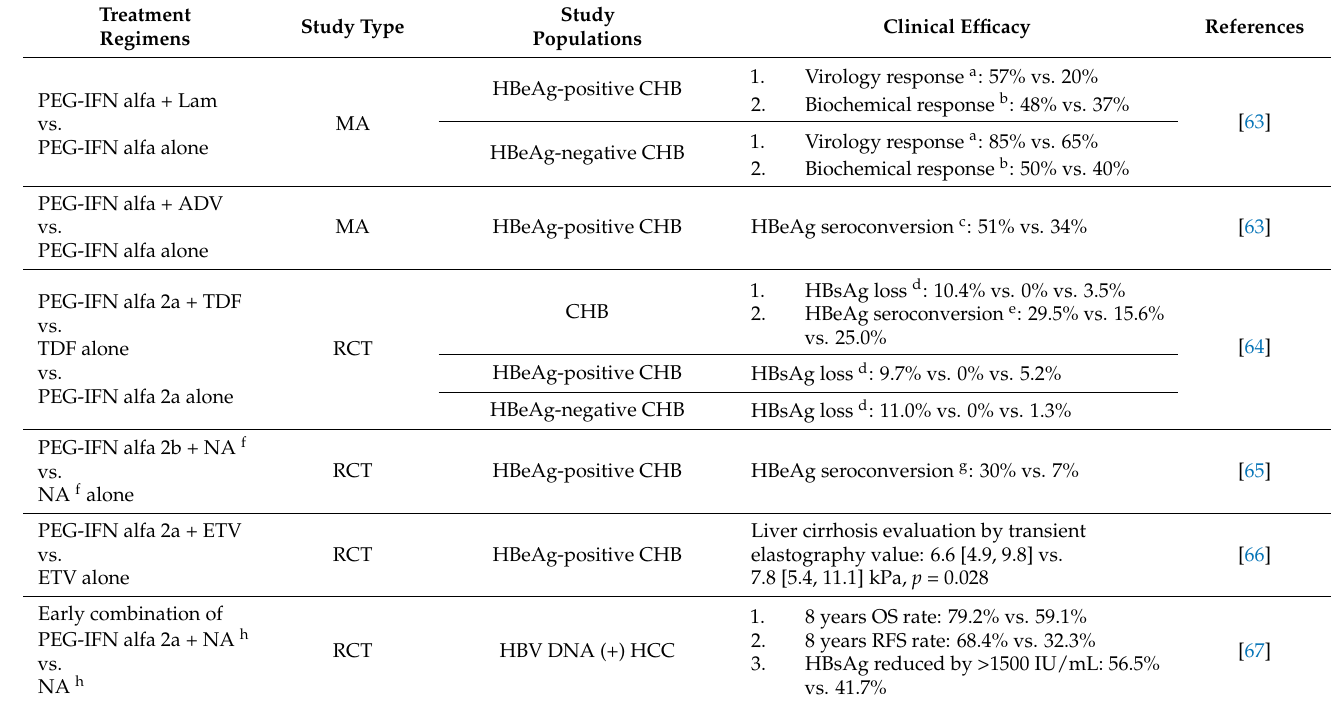
Table 3. Combinations of PEG-IFN alfa and NA therapies in the CHB